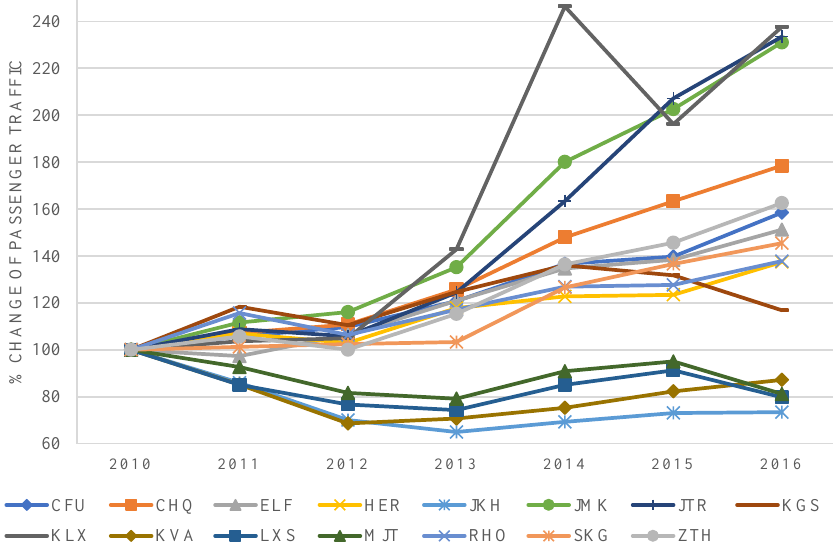
Figure 1. Evolution of passenger traffic in the study airports from 2010 to 2016.